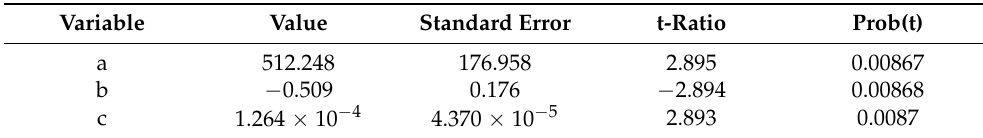
Table 2. Values of the coefficients of the mathematical model as a result of the regression for the considered data set.